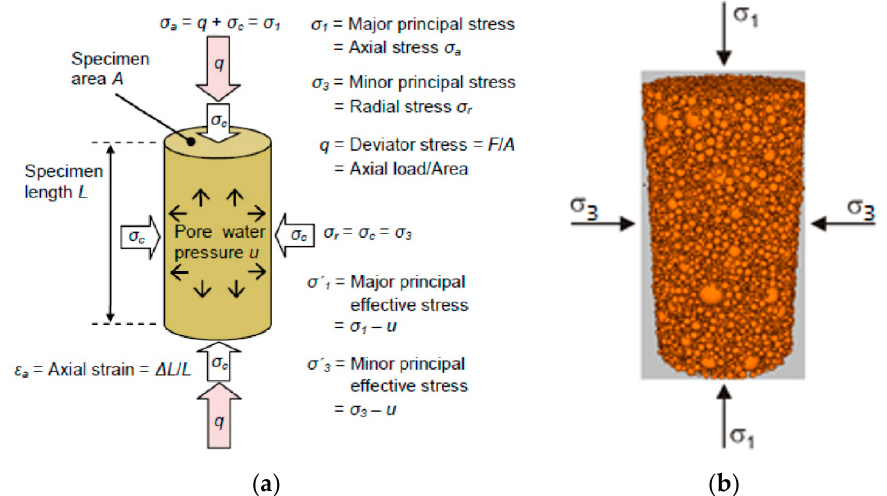
Figure 12. Specimen stress state in a triaxial compression test: retrieved from ( a ) Rees [99] and ( b ) Ahlinhan et al. [102].